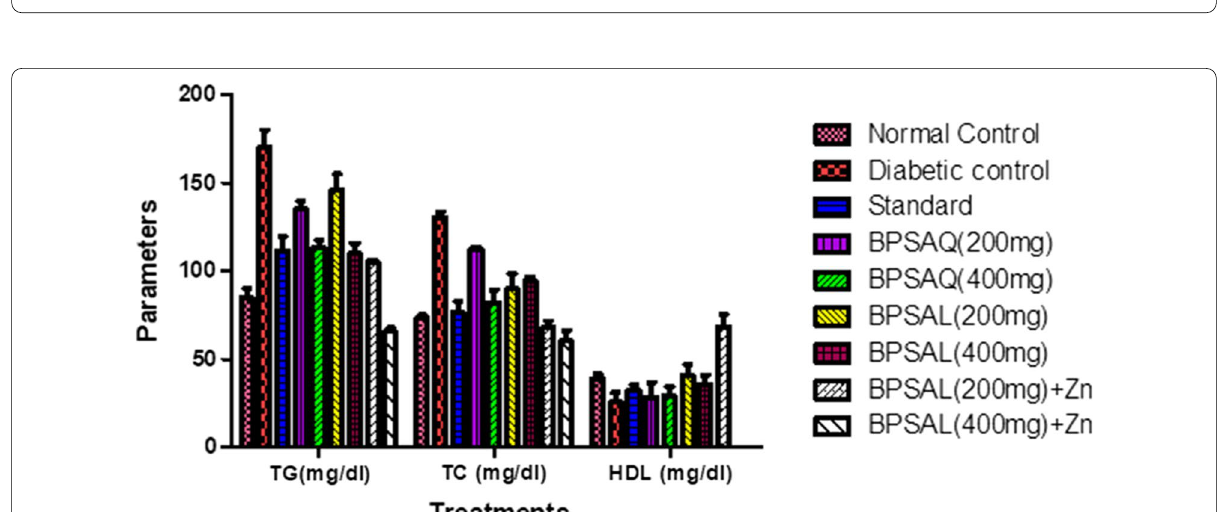
Fig. 11 Effect of extracts of B. pinnatum on FBG in streptozotocin-induced diabetic rats. Values are expressed as Mean significant from diabetic control group